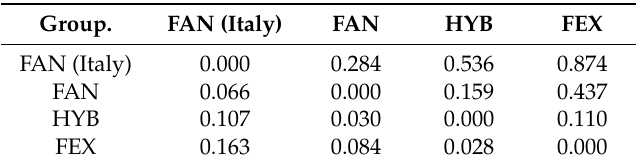
Table 3. Fst values (below diagonal) and Nei (1973) genetic distances (above diagonal) evaluated through nSSR on sample set #2. Each parameter was calculated for plants belonging to F. angustifolia collected in